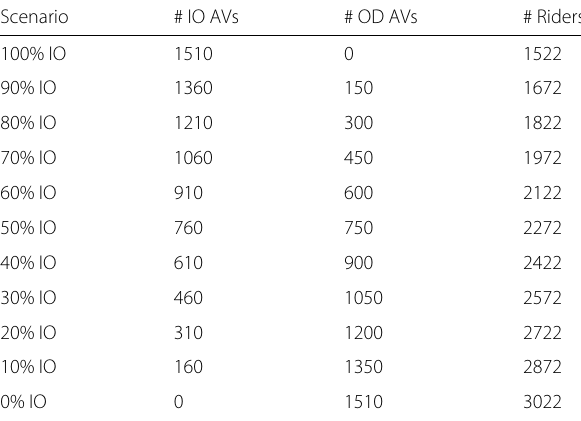
Table 3 Base case instance with different usage scenarios and 1-to-1 replacement